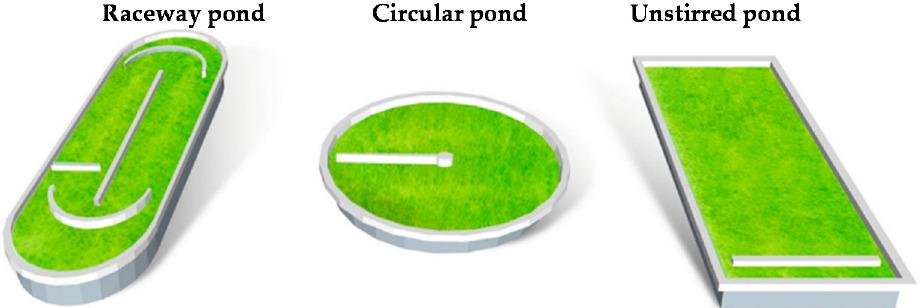
Figure 1. Schematic representation of close cultivation systems of microalgal cultivation.